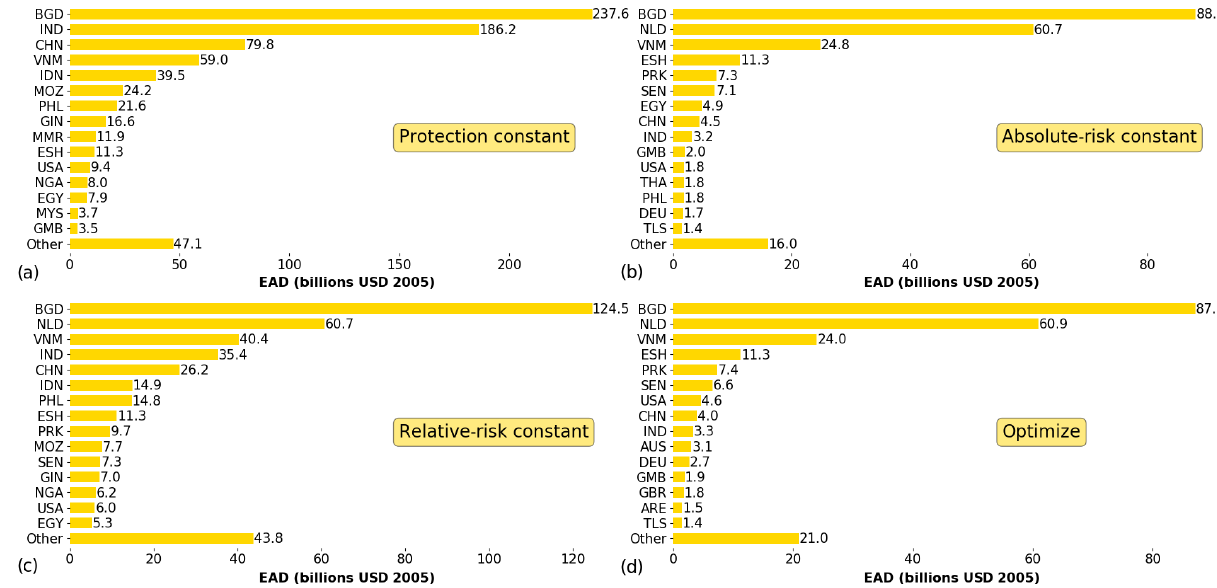
Figure 4. Top 15 countries with coastal flood risk in (a) 2080 if protection standards are kept constant, (b) 2080 if absolute risk is kept constant, (c) 2080 if relative risk is kept constant, and (d) 2080 if protection standards are optimized for the scenario RCP4.5–SSP2. Note that the countries and value on the x axis change for each graph. The countries are denoted by ISO 3166-1 alpha-3 codes.